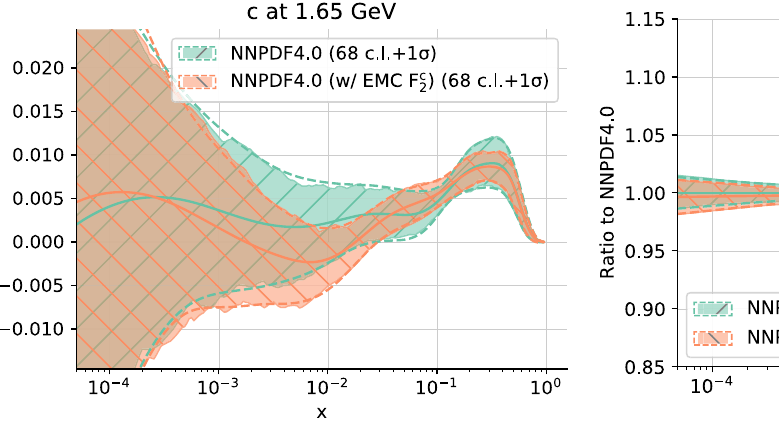
Fig. 42 (Left) Comparison to the baseline of the charm PDF at Q = 1 . 65GeVfromadeterminationinwhichtheEMCcharmstructurefunc- tion data [44] are included. (Right) The gluon PDF at Q = 100 GeV